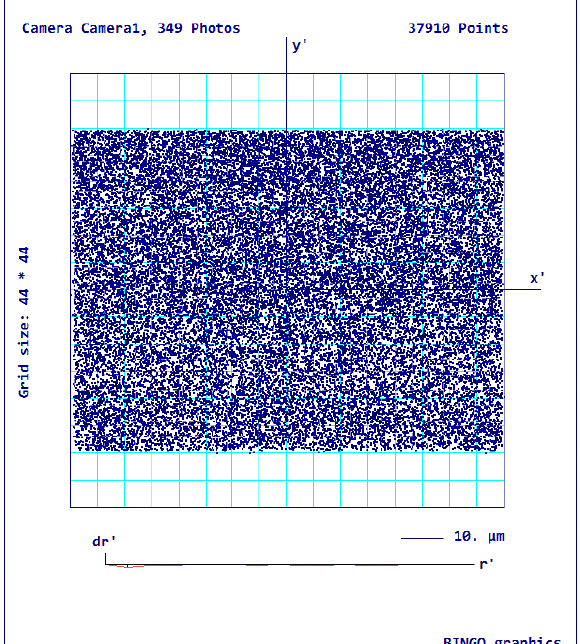
Figure 3: Point distribution of a selected camera, all points are projected into the image